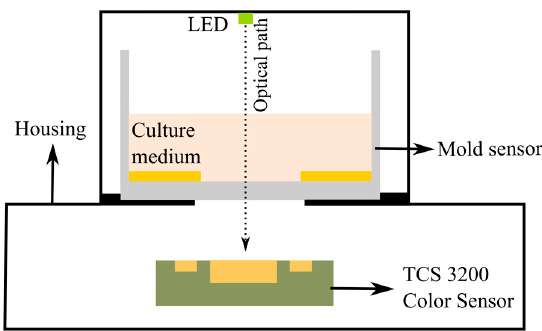
Figure 4. Sensor scheme for detection of color change during mold growth.